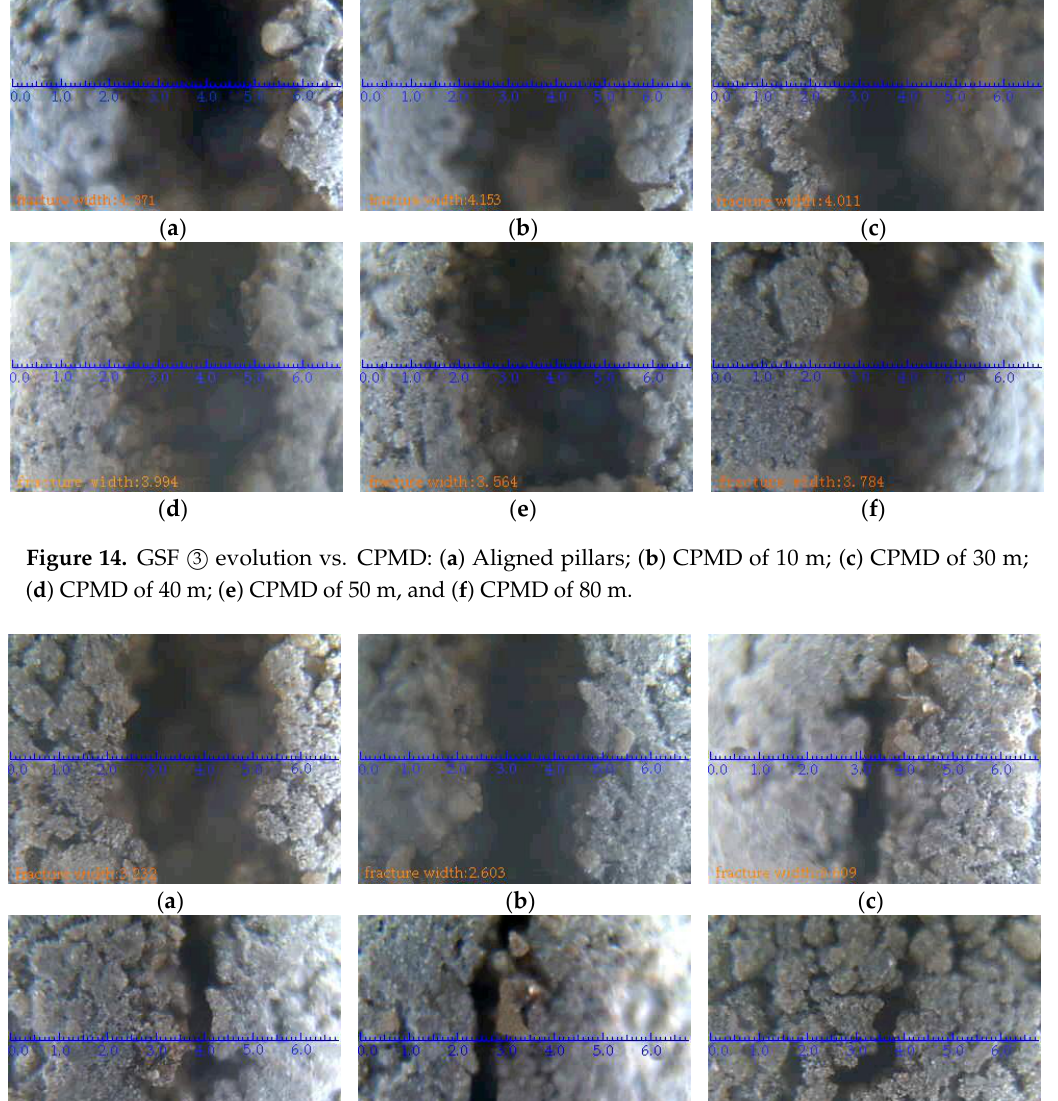
Figure 15. GSF ④ evolution vs. CPMD: ( a ) Aligned pillars; ( b ) CPMD of 10 m; ( c ) CPMD of 30 m;